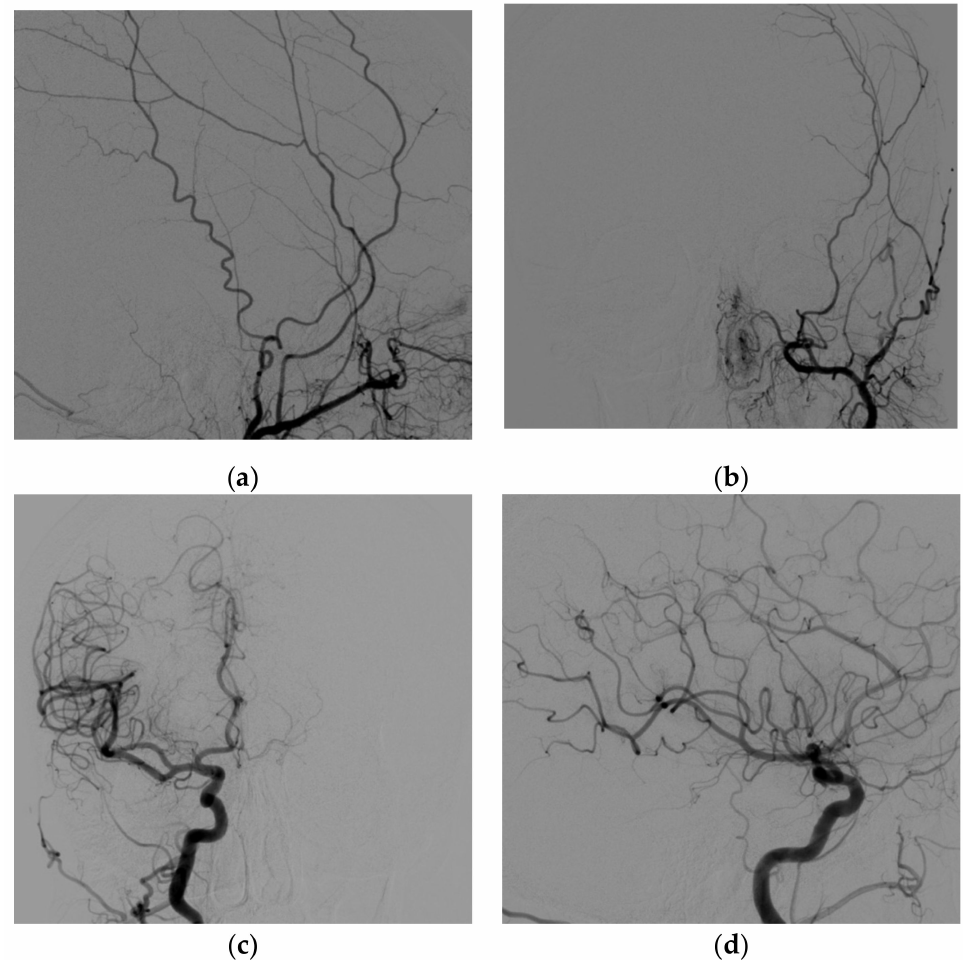
Figure 6. DSA at 7 months, left external carotid artery, lateral ( a ) and antero-posterior ( b ) views. right internal carotid artery antero-posterior ( c ) and lateral ( d ) view. The DSA shows complete resolution of the dural